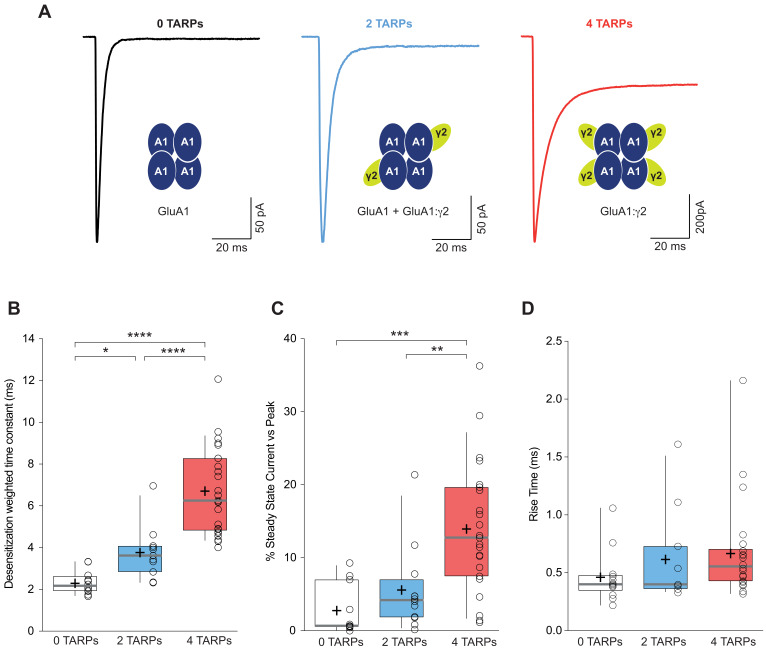
CP-AMPAR kinetics are differentially affected by AMPAR-TARP stoichiometry.(A) Traces evoked at −60 mV by rapid application of 10 mM glutamate to outside-out patches from cells expressing GluA1 alone (black; average of 39 responses) or together with 2 (blue; average of 37 responses) or 4 (red; average of 67 responses) γ2 subunits. (B) Pooled data of the weighted time constant of desensitization (τw, des). Box-and-whisker plots indicate the median value (gray line), the 25–75th percentiles (box), and the 10–90th percentiles (whiskers); crosses and open circles represent mean and the individual experimental values respectively. (C) Pooled data showing the increase in the steady state current only in 4 TARPed CP-AMPARs. (D) Rise time of glutamate-activated currents is not affected by TARPs. The data from this figure containing statistical tests applied, exact sample number, p values and details of replicates are available in ‘Figure 1—source data 1'.Figure 1—source data 1.Kinetic properties of CP-AMPARs.